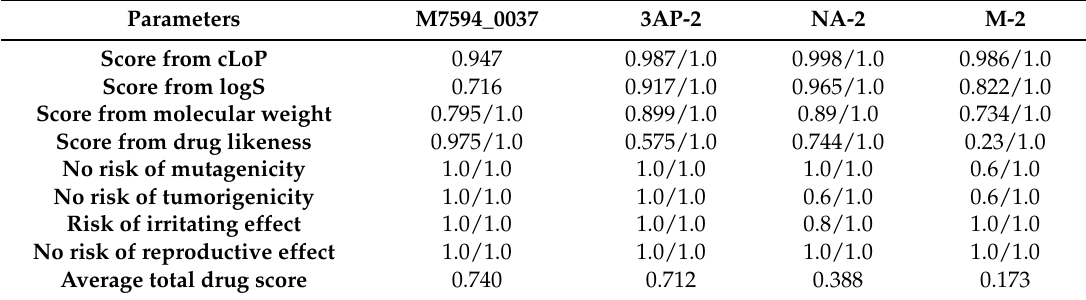
Table 3. Contribution of different parameters to the drug score of M7594_0037 and its